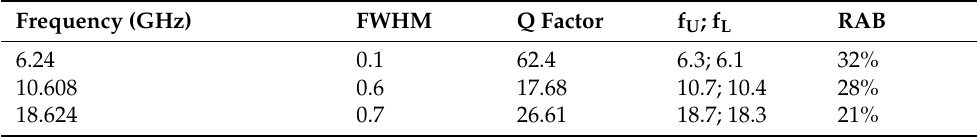
Table 1. The quality factor (Q), FWHM, and RAB results for TE mode.